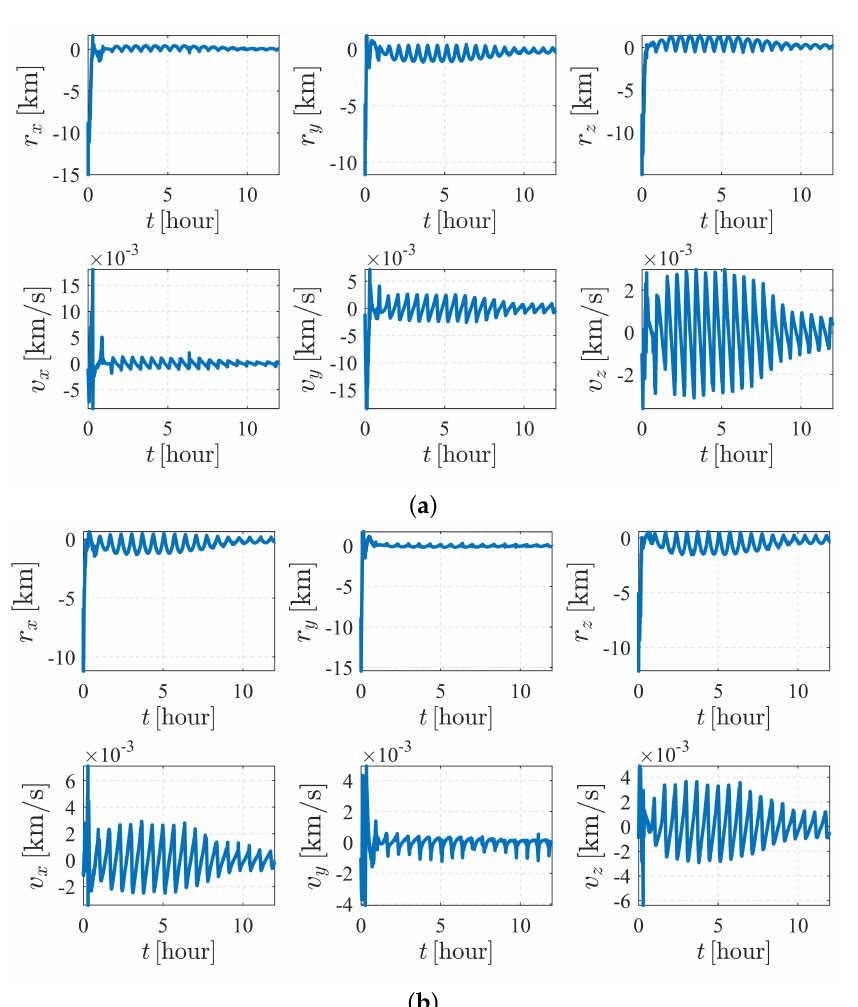
Figure 12. Orbit determination errors of case III (with J 2 , J 3 , and J 4 perturbations. ( a ) Orbit estimation errors of spacecraft S 1 . ( b ) Orbit estimation errors of spacecraft S 2 .